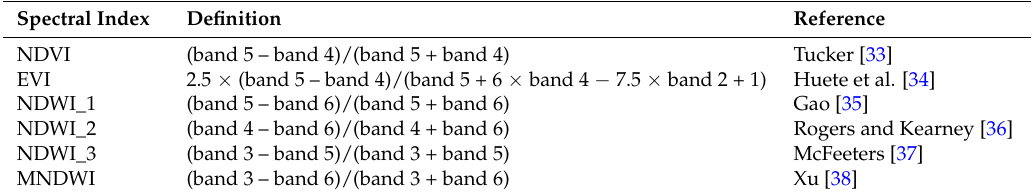
Table 1. Spectral indices calculated by the bands of Landsat-8 OLI data used in this study. Spectral